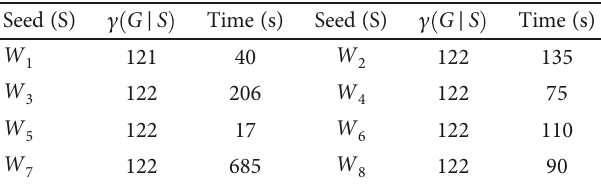
Figure 4: A dominating set with 120 vertices in C Table 3: The results for extending seeds from S .